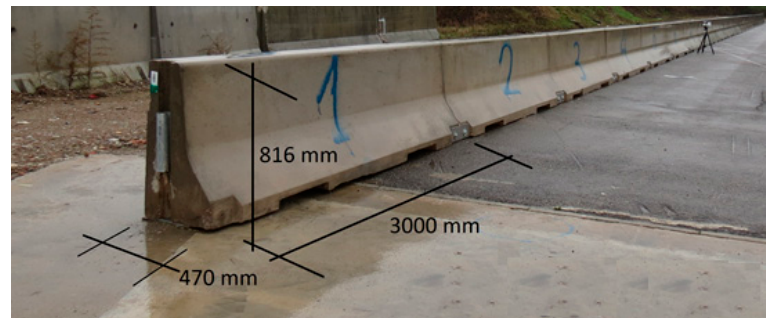
Figure 3. Dimensions of the single-sided concrete barrier.